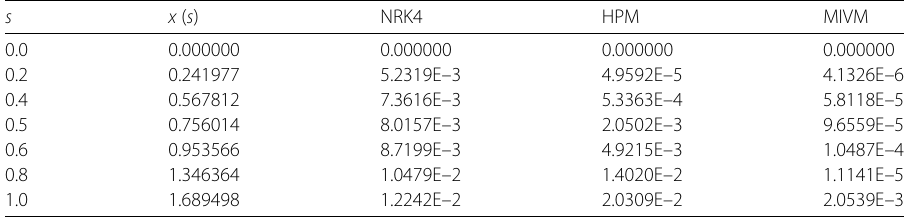
Table 4 Relative errors for Example 2, α = 1 s x ( s